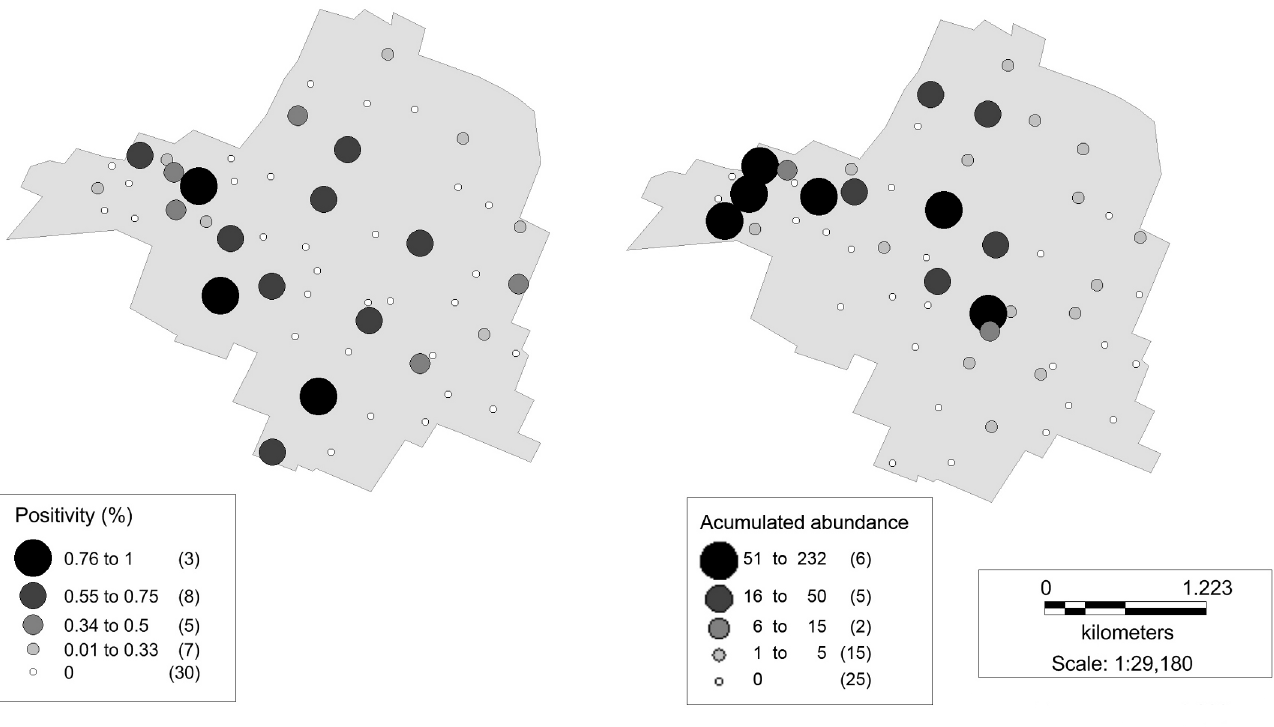
Fig 2. Land cover classification of the city. Land cover vectorial obtained after a non-supervised classification of the NDVI raster image. Sand-fly sampling sites are represented by the ▲ symbol. Areas of 50 m radius around the trap were used to calculate each type of cover proportion.